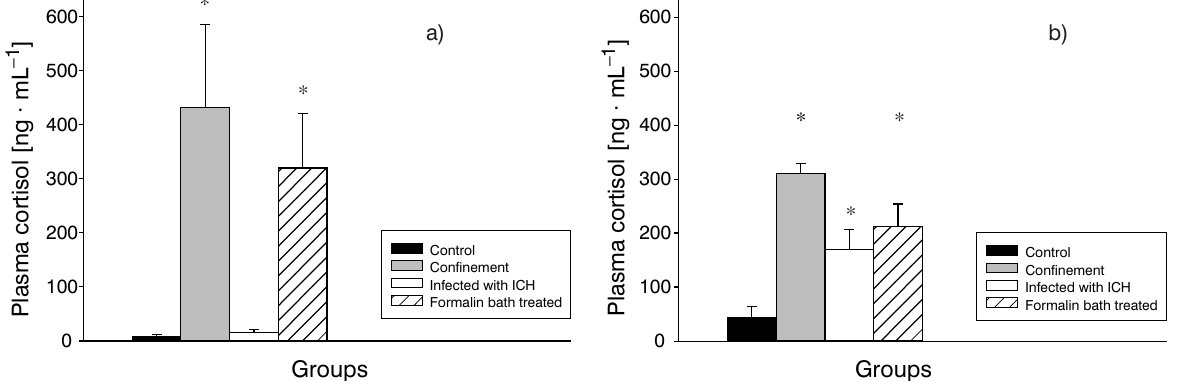
Fig. 1. Plasma cortisol concentration in each of the 4 experimental groups of rainbow trout on day 8 (a) and on day 16 (b); ( x ± s x ) ( n = 15) for all groups; * P < 0.05 (different from control